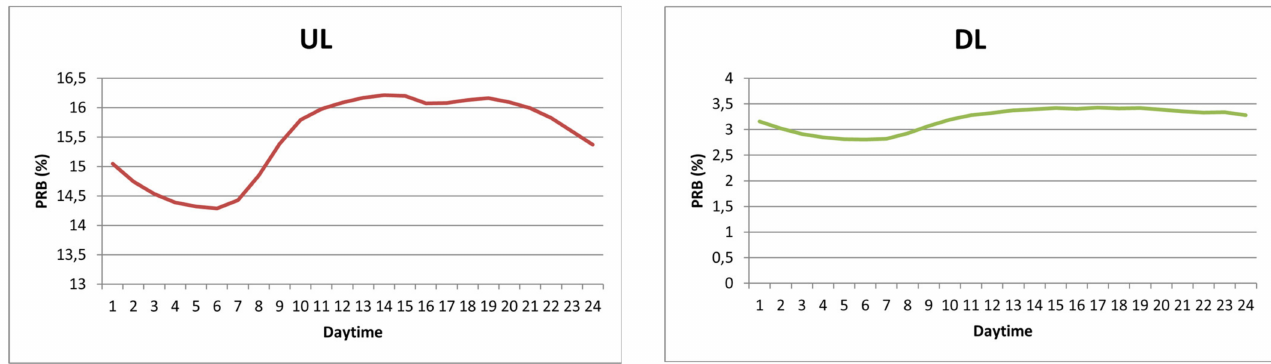
Figure 11. Daily evolution load (UL vs. DL) for 10 MHz.